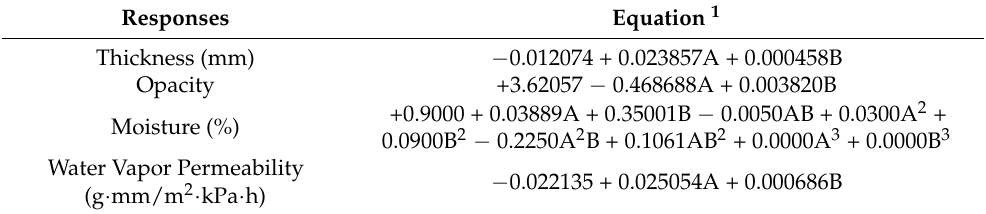
Table 3. Equation for responses.